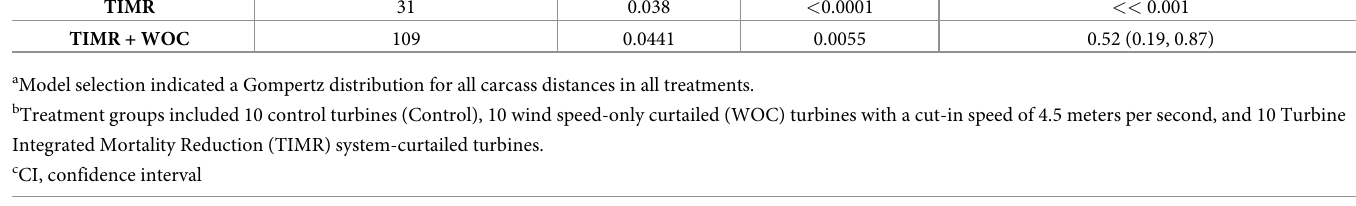
TIMR treatment may be artificially low. Fitted distributions and parameters are given in Table 2. Mortality was reduced by 47% at WOC turbines compared to control turbines (90% CI: -1%, 60%, where negative numbers indicate increased mortality and a finding of no differ- ence), and the TIMR strategy reduced fatalities by 75% (90% CI: 13%, 84%) compared to con- trol turbines (Table 3). The TIMR treatment reduced fatality rates by 1.5 (90% CI: -1.1, 4.1) times more than the WOC treatment.